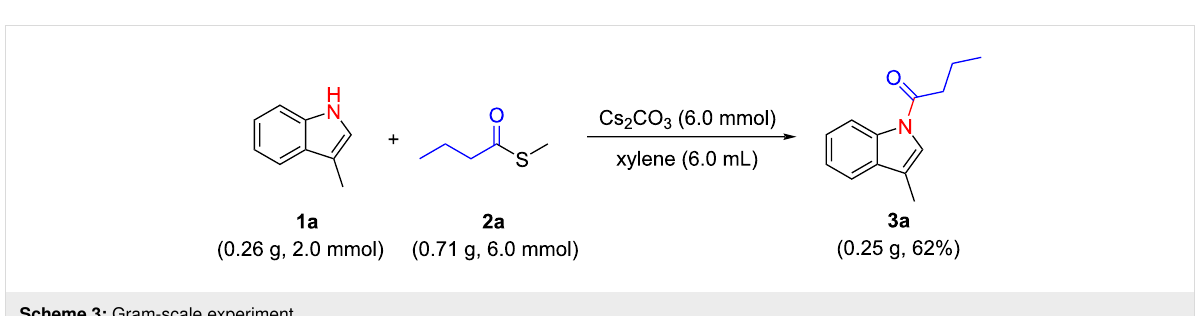
Scheme 3: Gram-scale